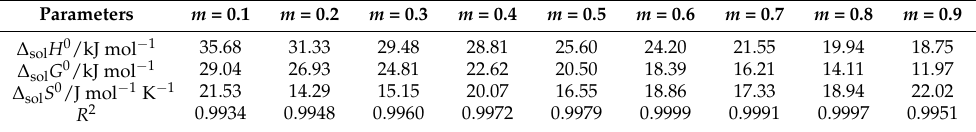
Table 13. Apparent thermodynamic quantities ( ∆ sol H 0 , ∆ sol G 0 , and ∆ sol S 0 ) and R 2 values for TRV in various PG + water compositions d